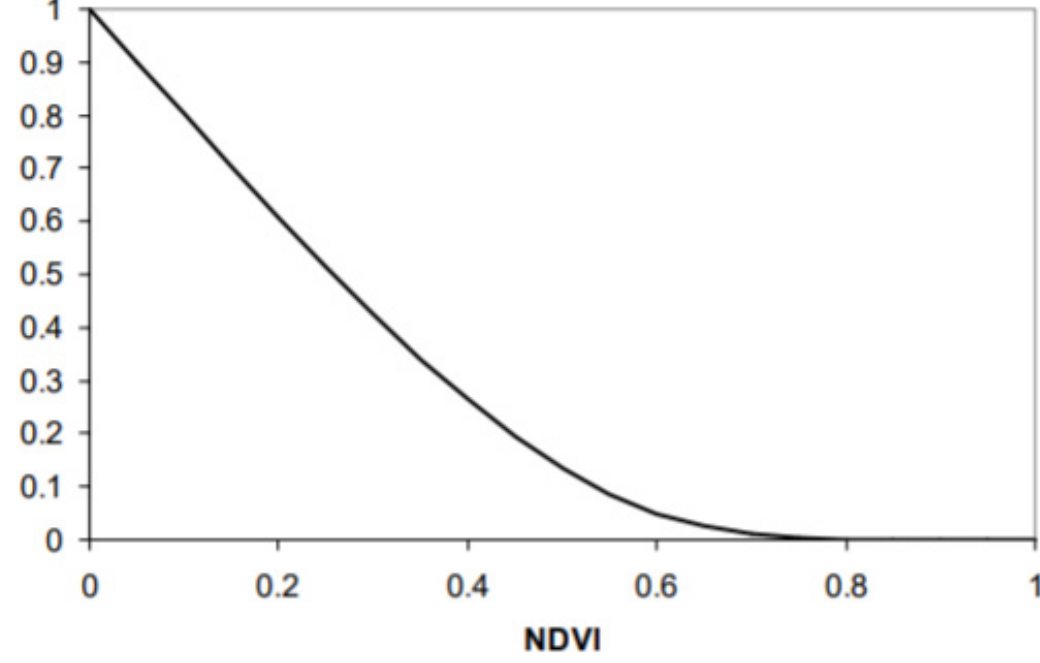
Figure 3. Relationship between Normalized Difference Vegetation Index ( NDVI ) and Cover Management Factor (C) using exponential scaling formula [31].